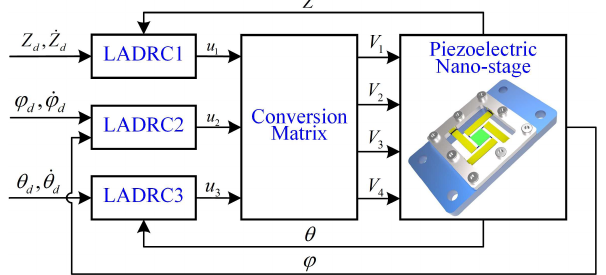
Figure 5. Block diagram of the attitude decoupling control